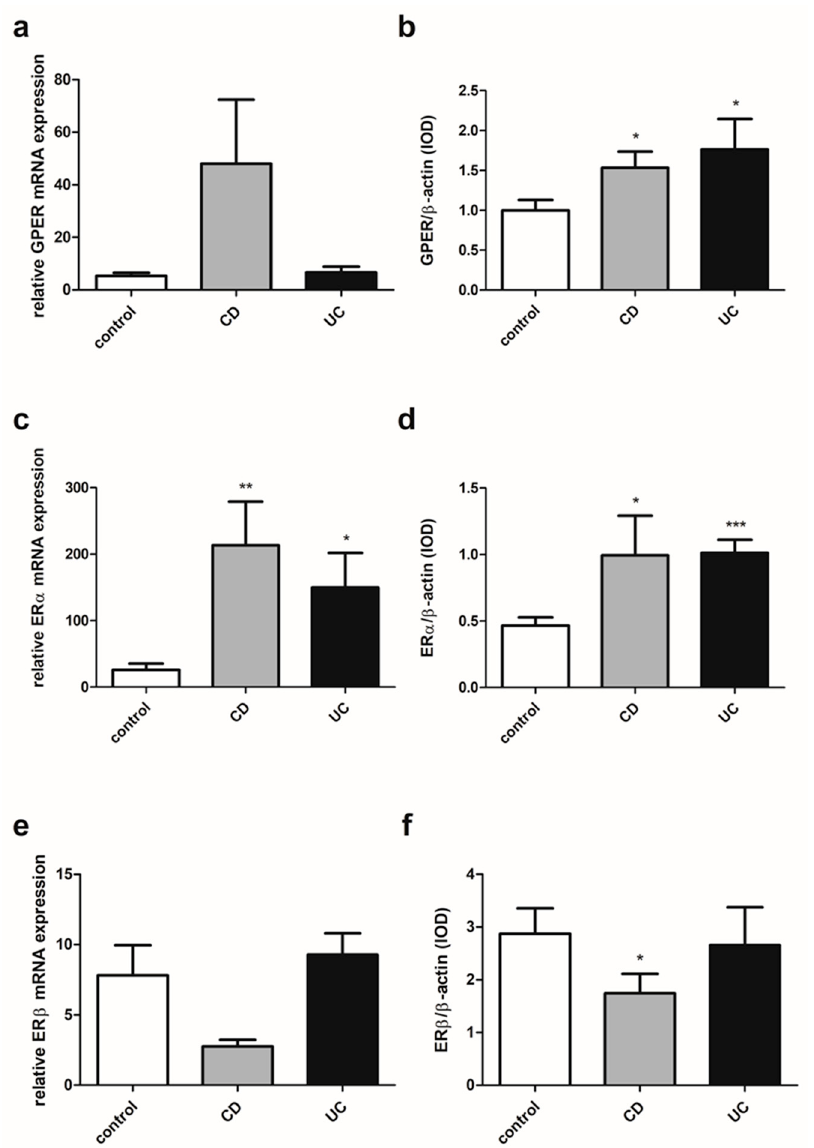
Figure 2. Expression of GPER ( a , b ), ER α ( c , d ) and ER β ( e , f ) at the mRNA ( a , c , e ) and protein level ( b , d , f ) in CD and UC patients and the control group regardless of sex and age (control, n = 31; CD, n = 31; UC, n = 42). Values are means ± SEM; * P < 0.05, ** P < 0.01, *** P < 0.001 vs. control.